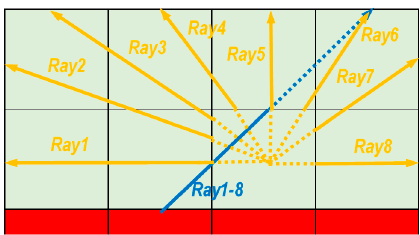
Figure 18. Yellow rays in the general ray model: The eight yellow rays start with the same blue part.